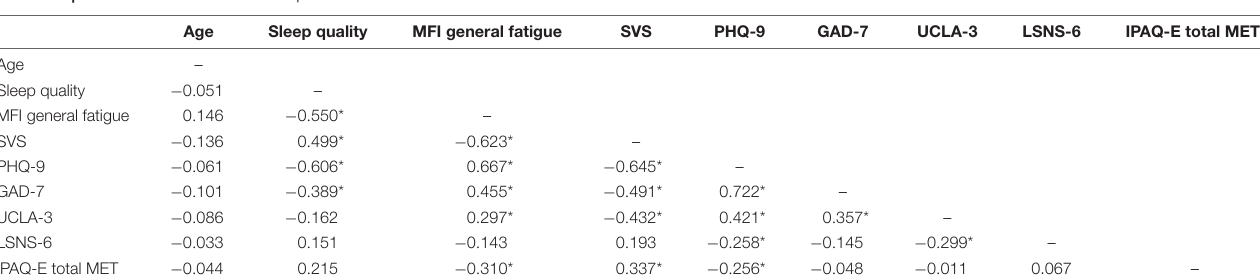
TABLE 4 | Correlation matrix and descriptive statistics for continuous